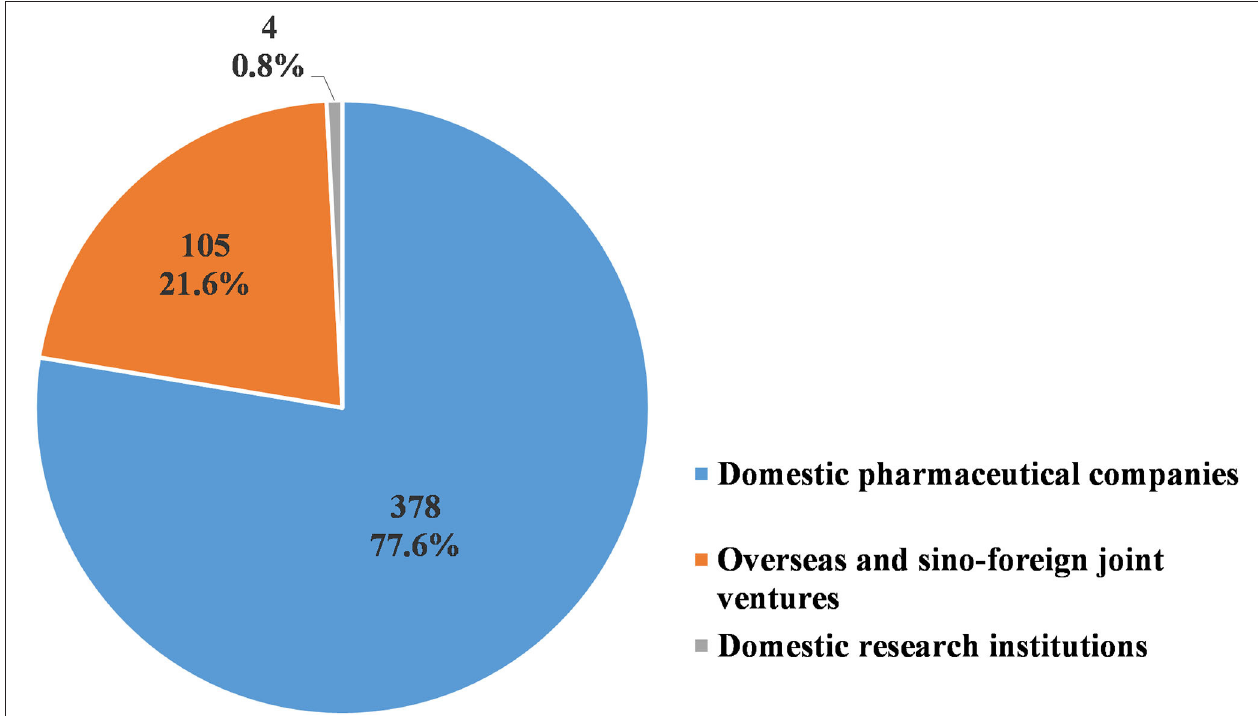
FIGURE 9 | Sponsorship of pediatric clinical trials.